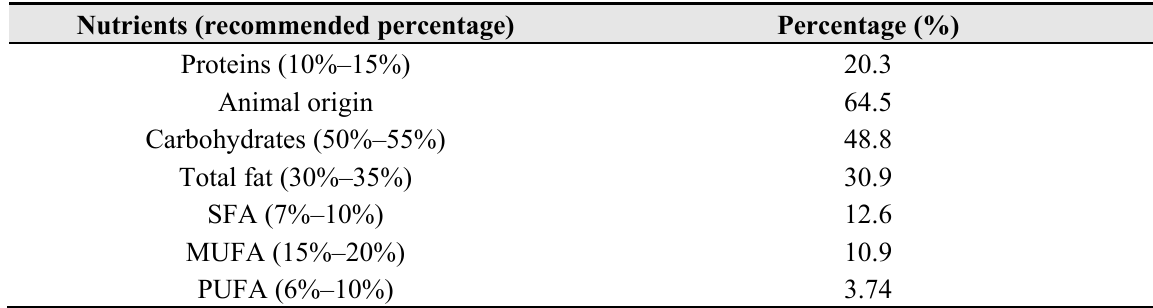
Table 2. Percentage contribution of immediate principles and fatty acids to daily calorie intake in the whole